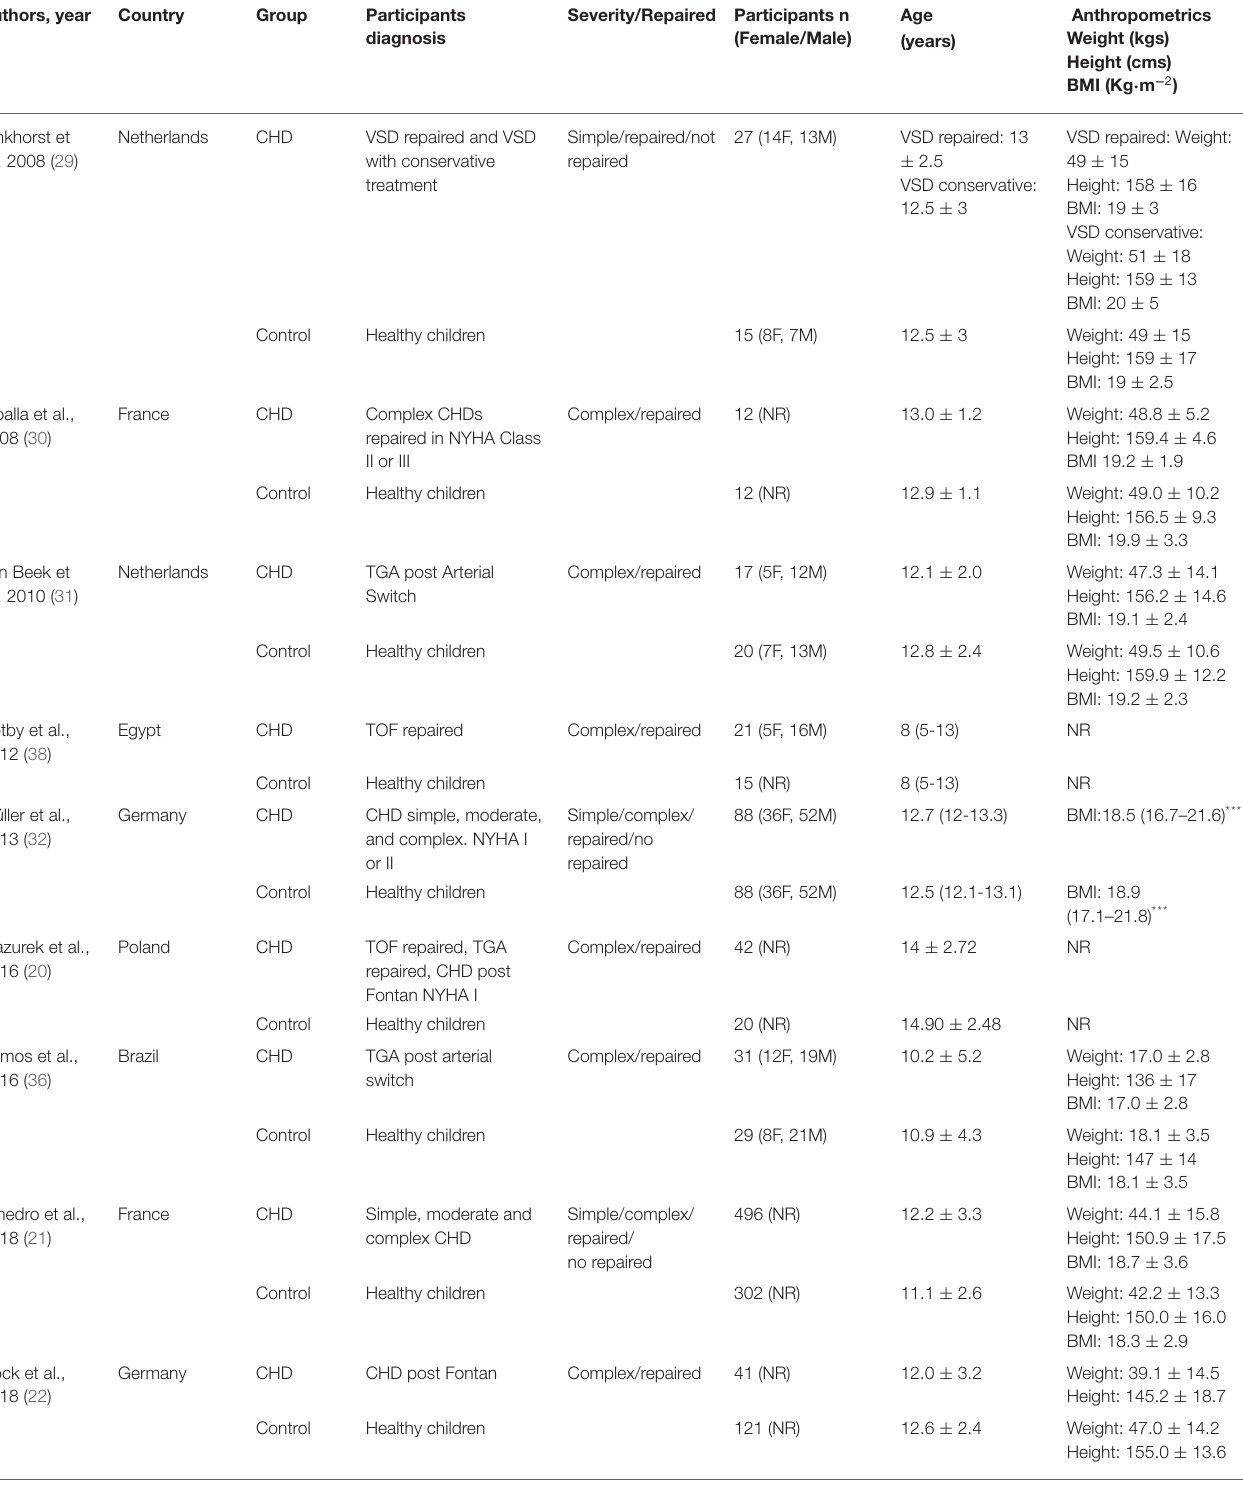
Weight: 47.0 ± 14.2 Height: 155.0 ±